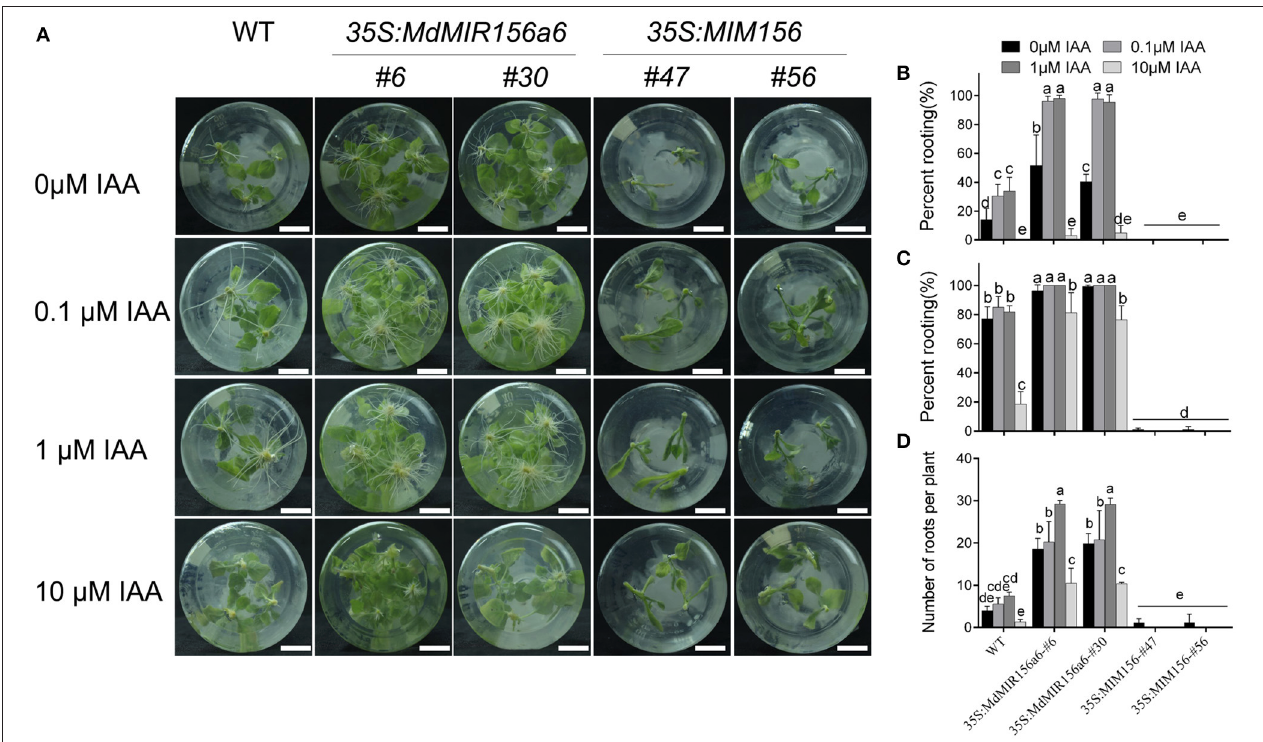
FIGURE 5 | Effects of IAA on adventitious root formation of 35S:MdMIR156a6 and 35S:MIM156 tobacco plants. (A) Phenotypes of 13-day-old plants (WT, 35S:MdMIR156a6, and 35S:MIM156 ) grown on MS medium with or without IAA treatment. Scale bars = 15mm. (B,C) Percent rooting of tobacco stem cuttings grown on MS medium for 7 and 14 d, respectively. (D) Adventitious root number per cutting. Adventitious root number was counted after 14 d on MS medium. Bars show SD with three biological replicates; n = 5 cuttings in each replicate. The statistical analysis was performed by Duncan’s multiple range test at level p ≤ 0.05. The same lowercase letter indicate no significant